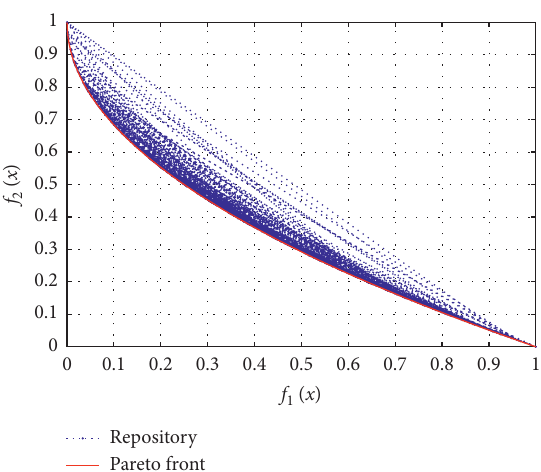
Figure 4: Pareto front produced by MOLFA for the ZDT2 test function.